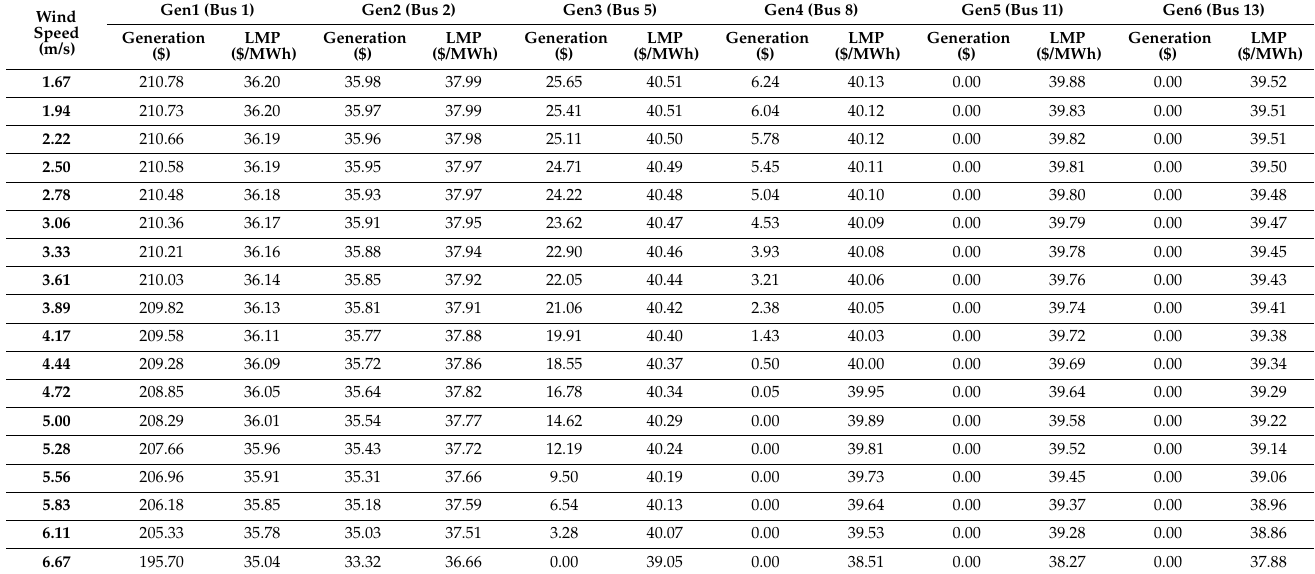
Figure 5. Generation (in MW) and LMP (in $/MWh) after wind placement. Table 6. Generation and LMP calculation of modified IEEE 30-bus system after WF